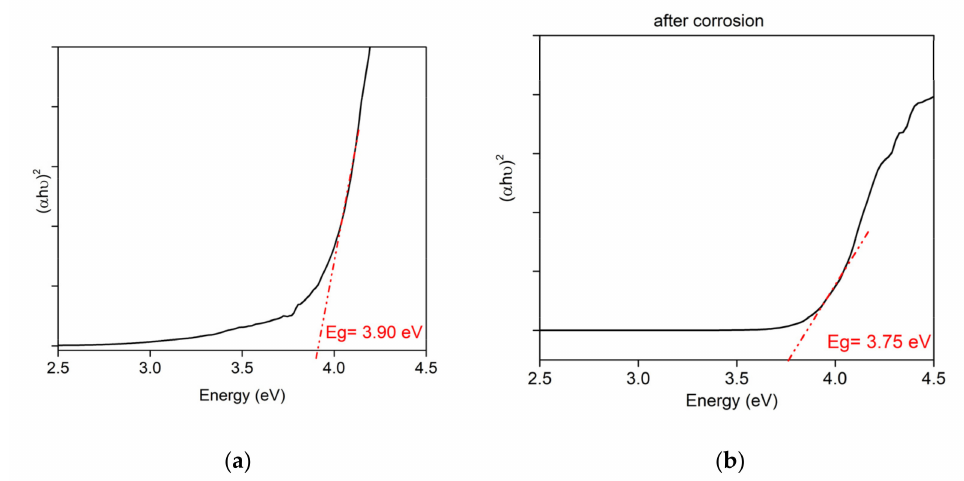
Figure 6. Tauc plot for band gap (Eg) determination of the 50%ZnO50%Ta 2 O 5 thin film ( a ) before and ( b ) after